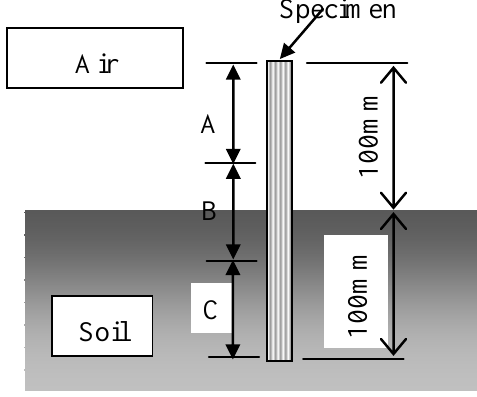
Figure 3. Schematic illustration of the biodegradable test (Condition 2).